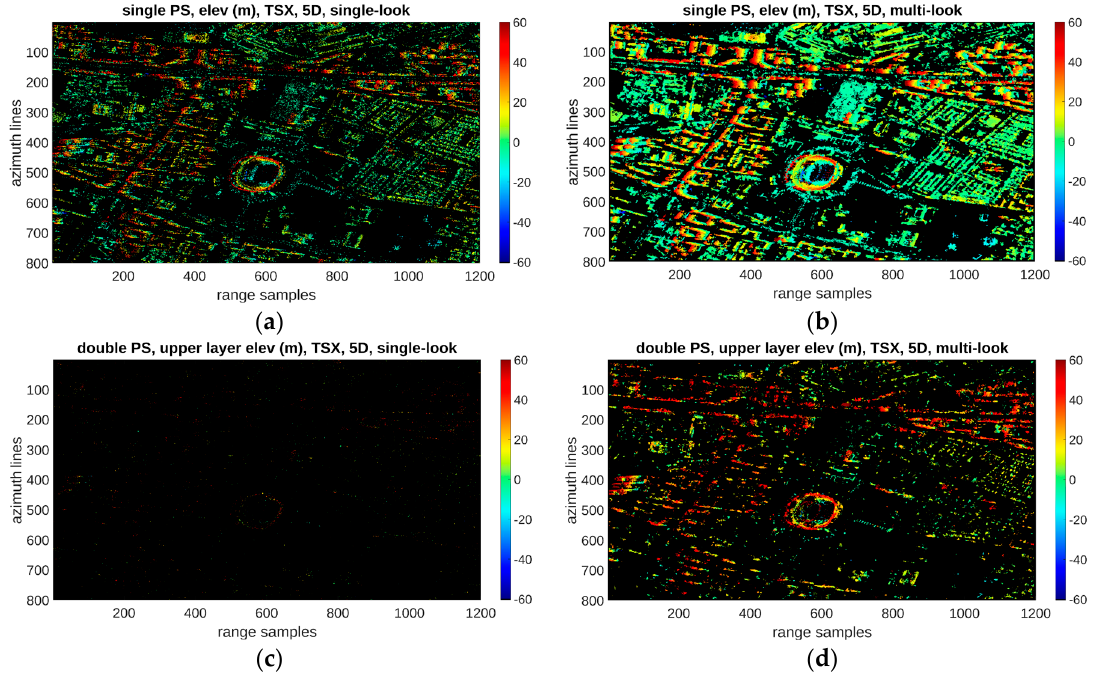
Figure 4. Distribution of the detected single scatterers ( a , b ) and higher double ( c , d ) scatterers, for single-look ( a , c ) and multi-look ( b , d ) analysis. Colormap is in meters and set according to the estimated